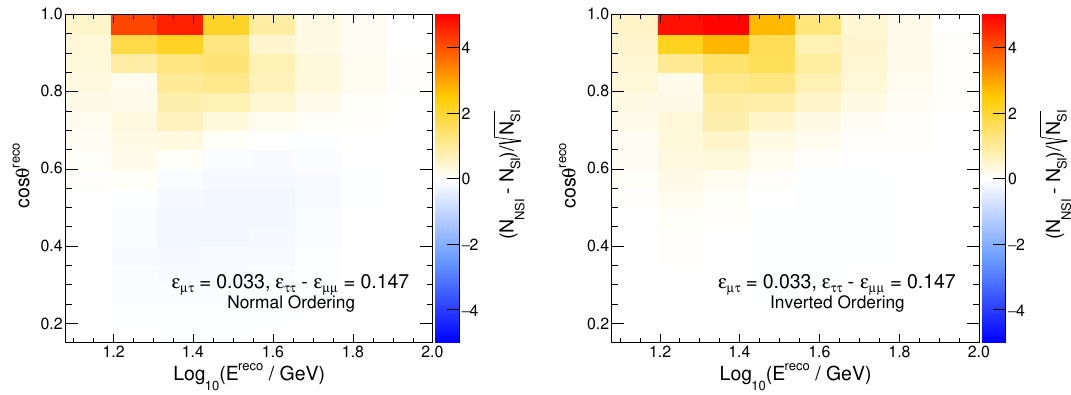
Figure 2 . Difference of number of events with and without NSI as a function of the reconstructed neutrino energy ( log ( E reco )) and direction (cos θ reco ). Both panels correspond to a NSI test point, 10 parameterised by ε αβ as quoted on the plots for normal (left) and inverted (right) orderings. and 10 1 . 2 = 15 . 8 GeV, plus seven bins equally logarithmically spaced between 10 1 . 2 and 10 2 GeV. The reconstructed cos θ reco is divided into seventeen bins between 0.15 and 1.0, the latter value corresponding to vertically up-going events. The difference in the number of events expected with NSIs (assuming a trial set of values of model parameters, quoted on the plots) and without NSIs is shown in figure